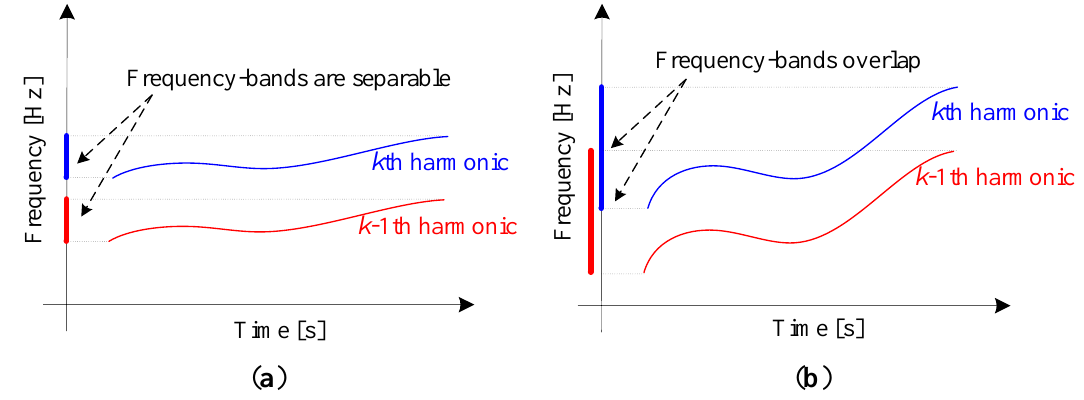
Figure 1. Time-frequency distribution and frequency-bands of harmonics: ( a ) Small speed variation; ( b ) Large speed